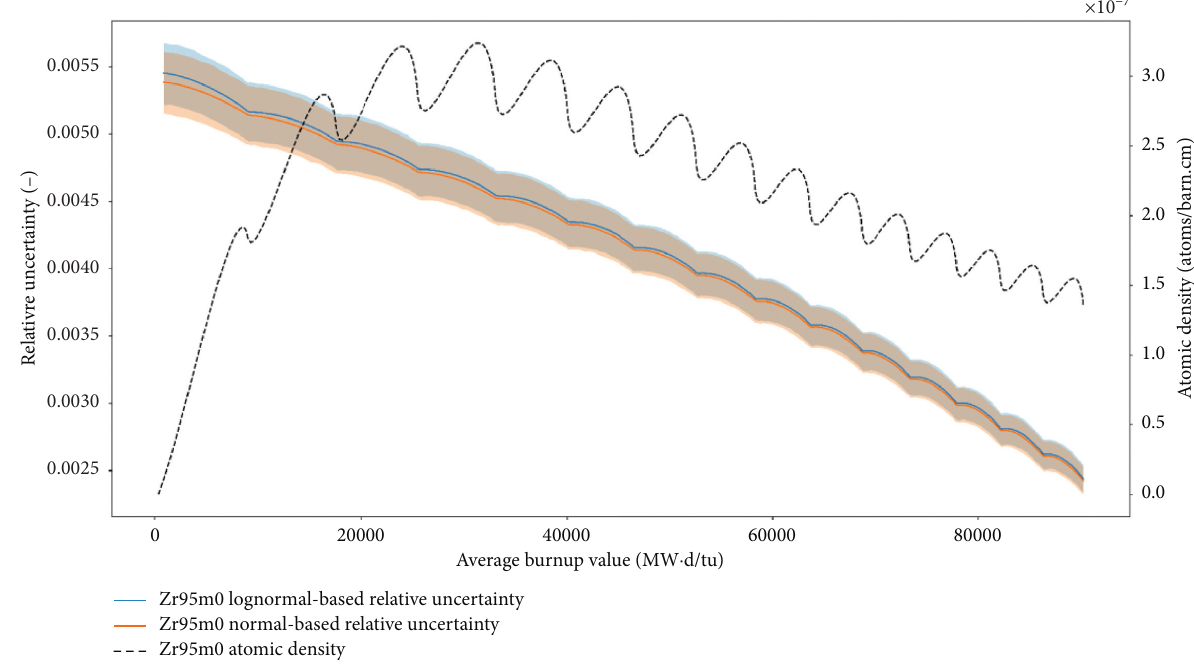
Figure 19: Relative uncertainties of Zr95m0 against fuels average burnup values. Lognormal-based sampling results (blue line) and normal- based sampling results (orange line) are plotted. The shades in this figure are the 95% confidence interval of relative uncertainties.